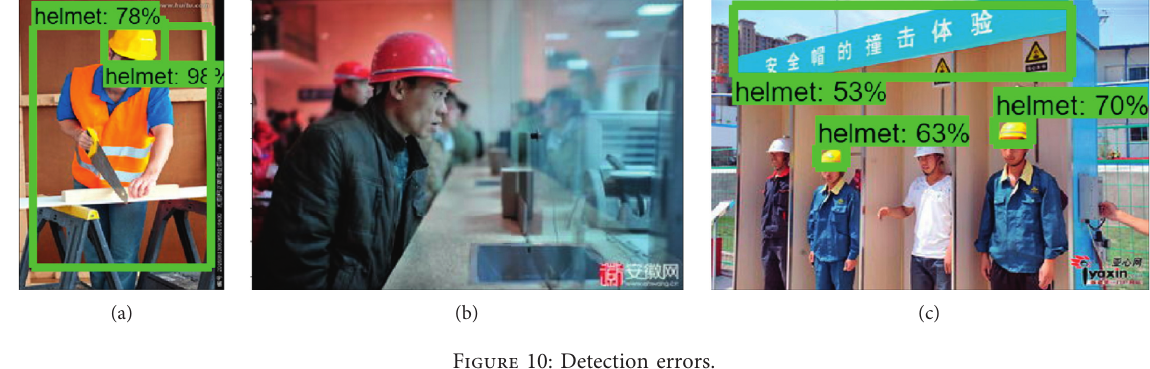
Figure 10: Detection